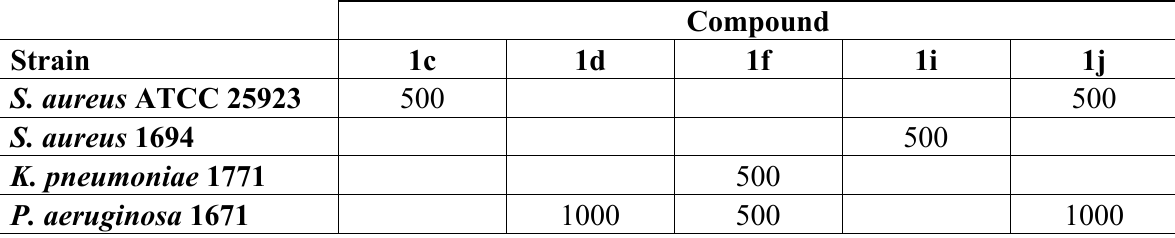
Table 2. Results of the quantitative assay of MIC for the compounds proving to be active in the qualitative screening on the respective bacterial strains (MIC values expressed in μ